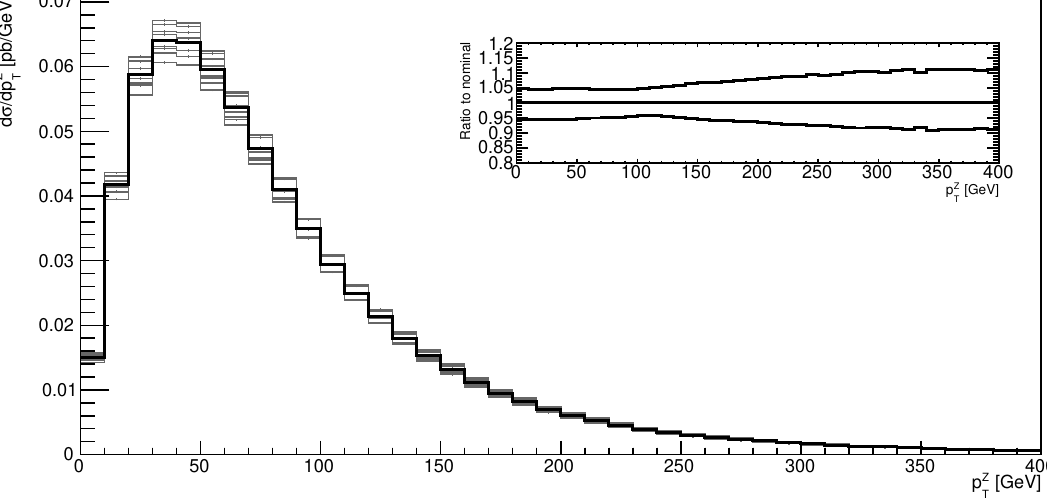
Figure 11 . The e(cid:11)ects of scale variations in the di(cid:11)erential cross section of the SM WZ process as a function of the Z p T . Here, aMC@NLO and Pythia 8 were used to generate the events. The thick black line represents the spectrum at the nominal scale, and each grey line is a variation of the scale. The insert shows the maximum and minimum relative deviations for all scale